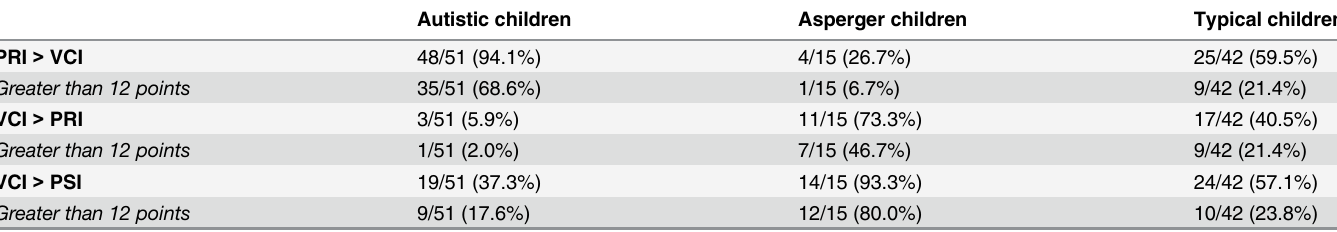
Table 3. Discrepancies between WISC-IV indexes. Autistic children Asperger children Typical